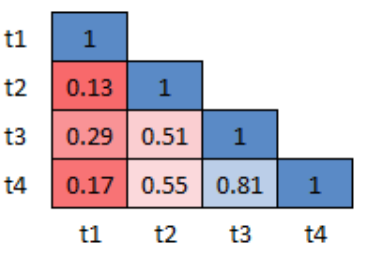
Fig. 11 Inter-sessions test-retest validation for version 2: Heatmap showing the average p-values for the 4 sessions across participants